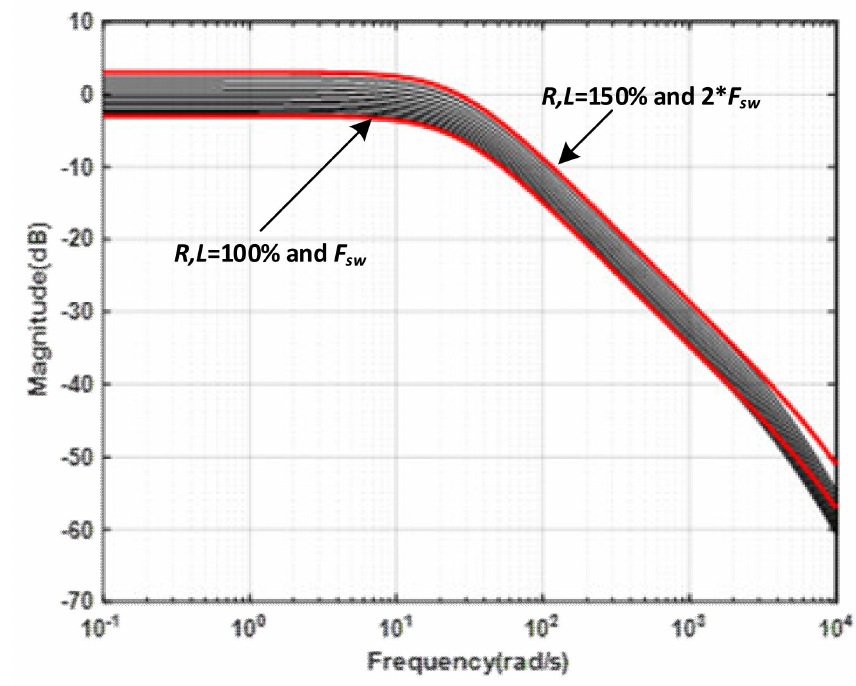
Figure 8. Magnitude plots of perturbed plant transfer